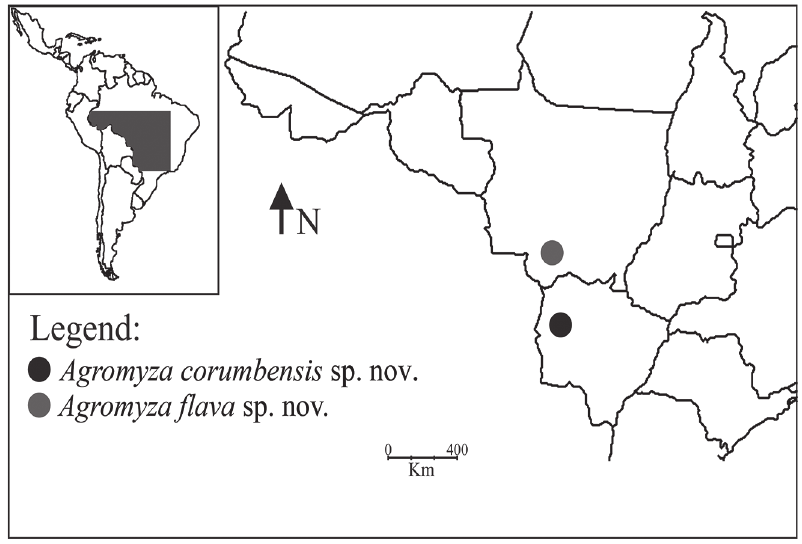
Figure 1 - Map with the collected localities of the new Agromyza Fallén